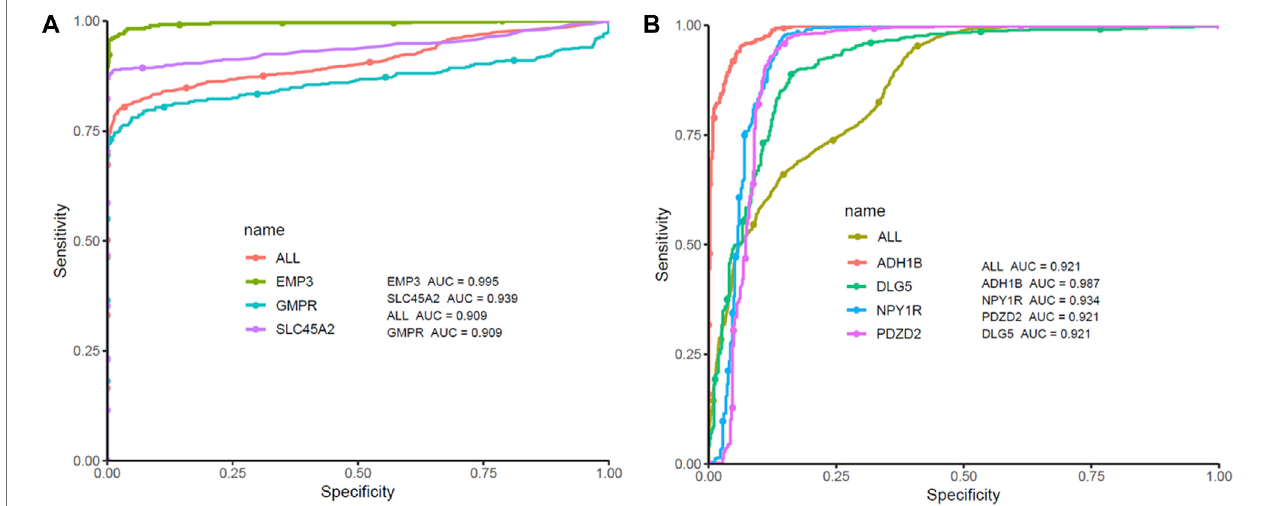
FIGURE8| ROCcurveanalysisandAUCanalysiswereimplemented toevaluatethecapacityofsevengenestodistinguishCMtissuefromnormaltissueinTCGA- GTEx dataset. (A) ROC curves analysis of three screened up-regulated genes (GMPR, EMP3, SLC45A2). (B) ROC curves analysis of four screened down-regulated genes (PDZD2, NPY1R, DLG5, ADH1B).